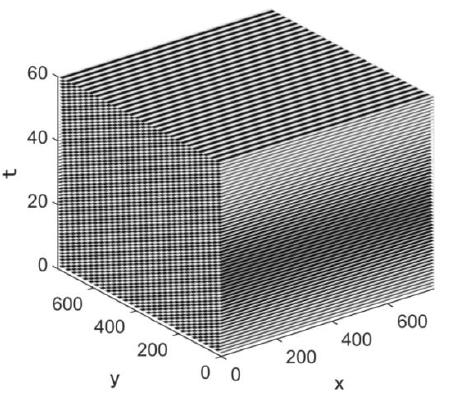
Figure 1. Schematic diagram of fringe image sequence.